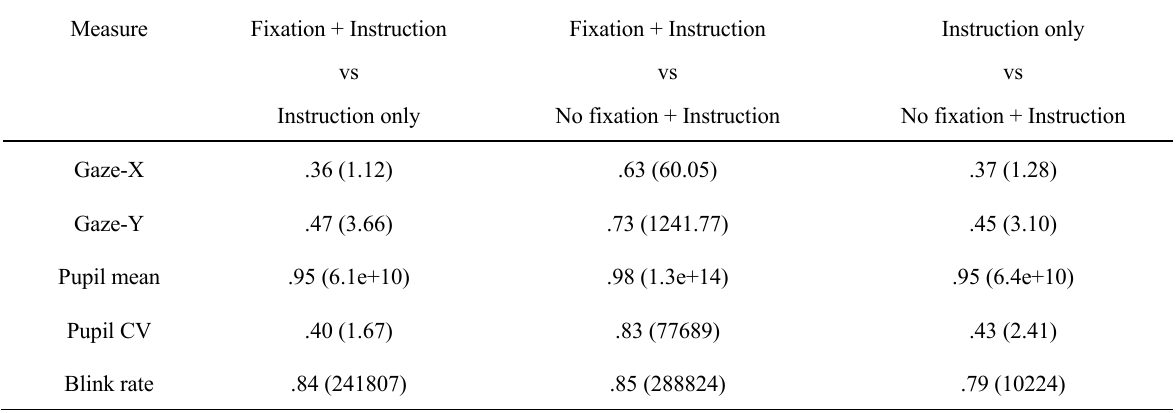
Table 2. Overview of the intra-individual reliability across conditions for each of the measures from Experiment 3. For each pair of conditions and each measure, the correlation coefficient is shown, with the accompanying BF10 in brackets.